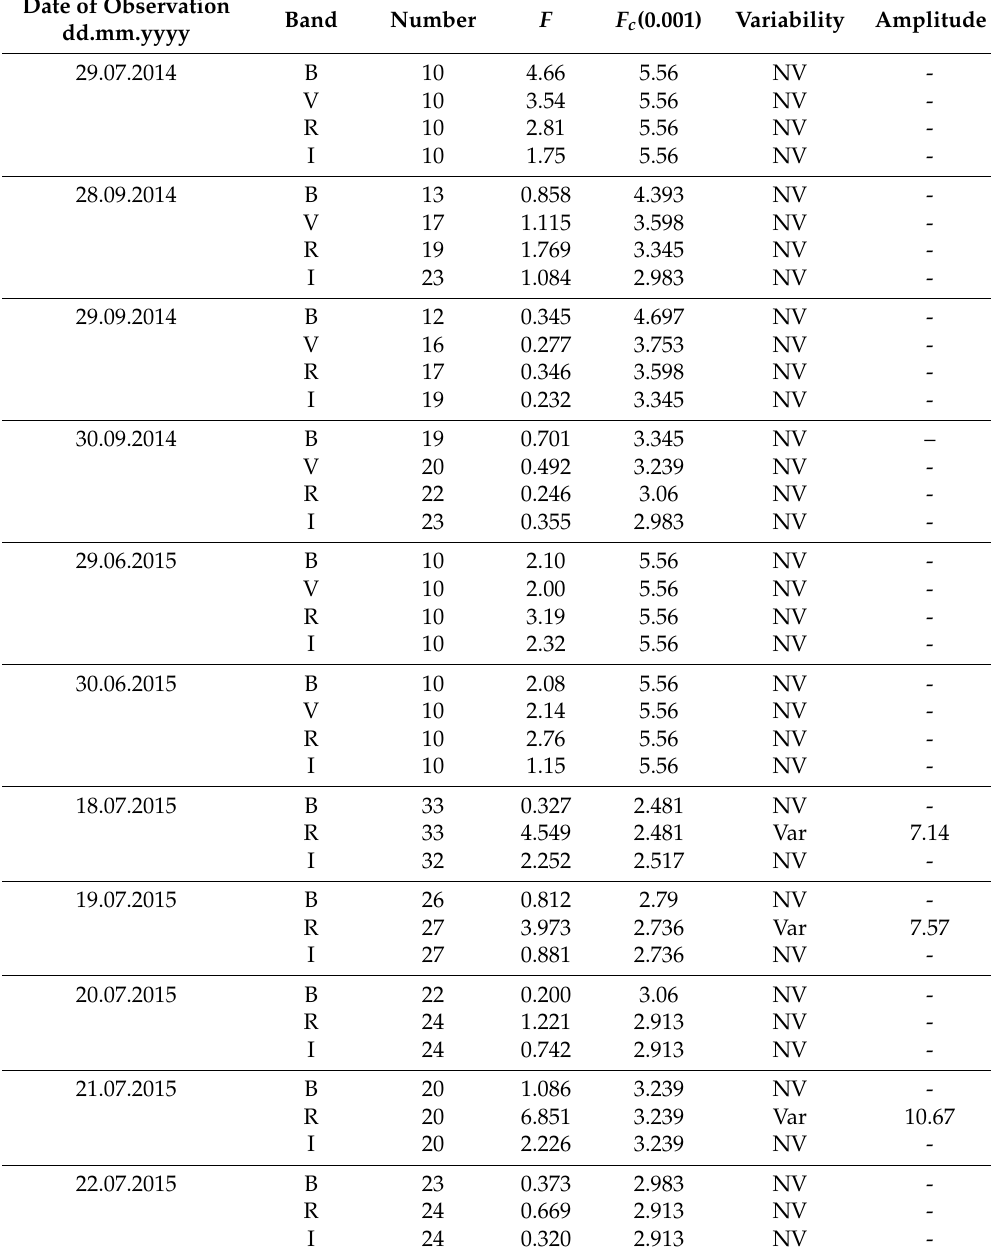
Table 2. Results of intra-day